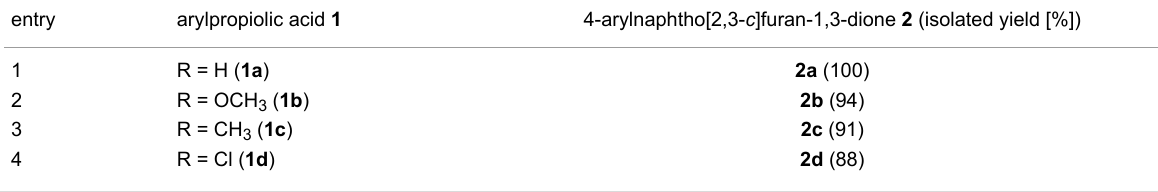
Table 2: Synthesized 4-arylnaphtho[2,3- c ]furan-1,3-diones 2 .